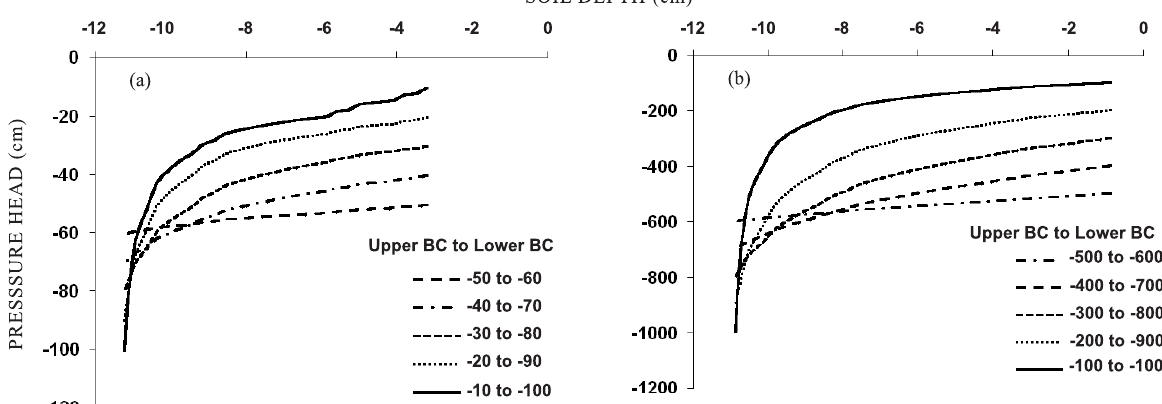
Figure 4. Pressure head distribution as related to depth in the layered system. Near-saturation range (a) and drier range